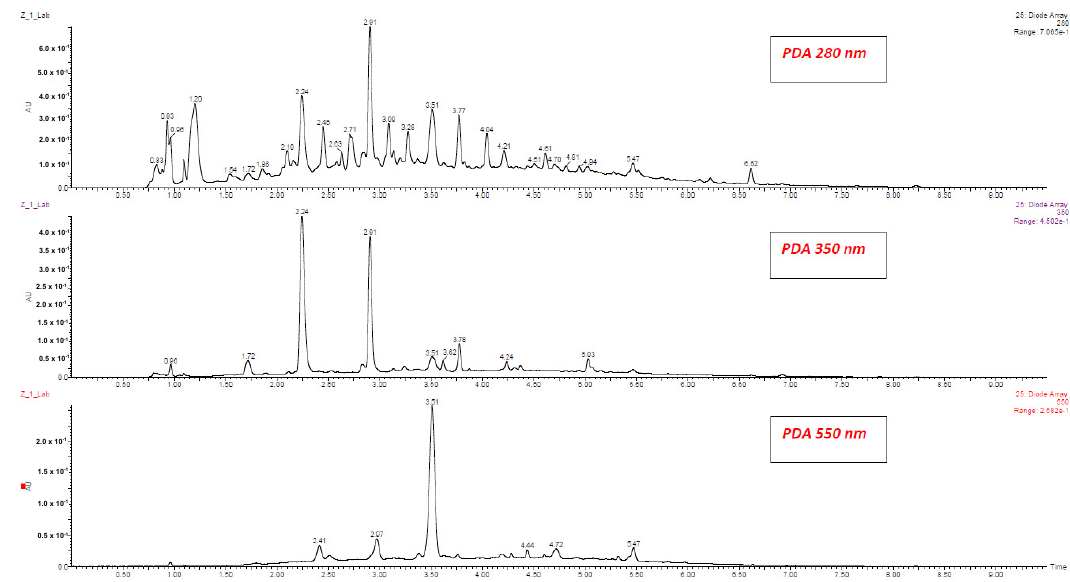
Figure 2. UPLC-PDA chromatograms of phenolic compounds in Zweigelt wine at 280, 350 and 550 nm .